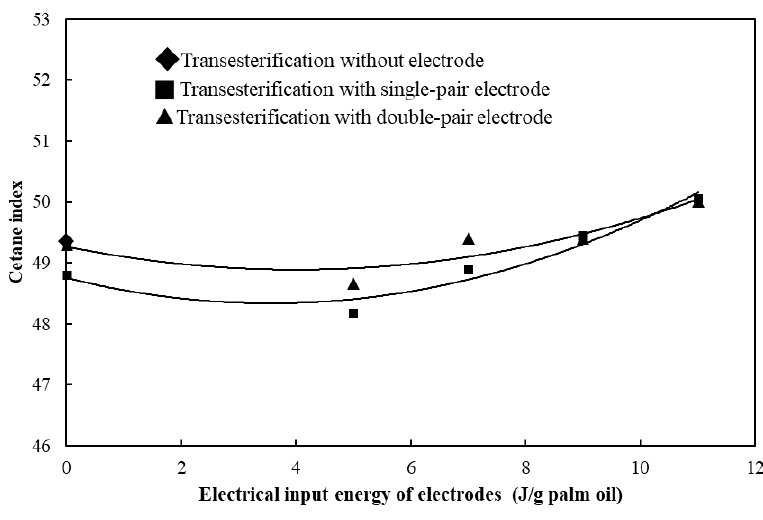
Figure 12. Effects of electrical energy input for dissociating water on the cetane index of biodiesel